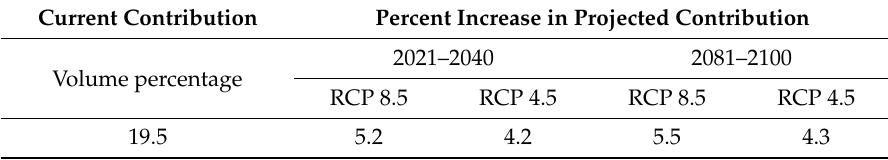
Table 2. Runoff contribution of Gilgel Abbay to Lake storage.